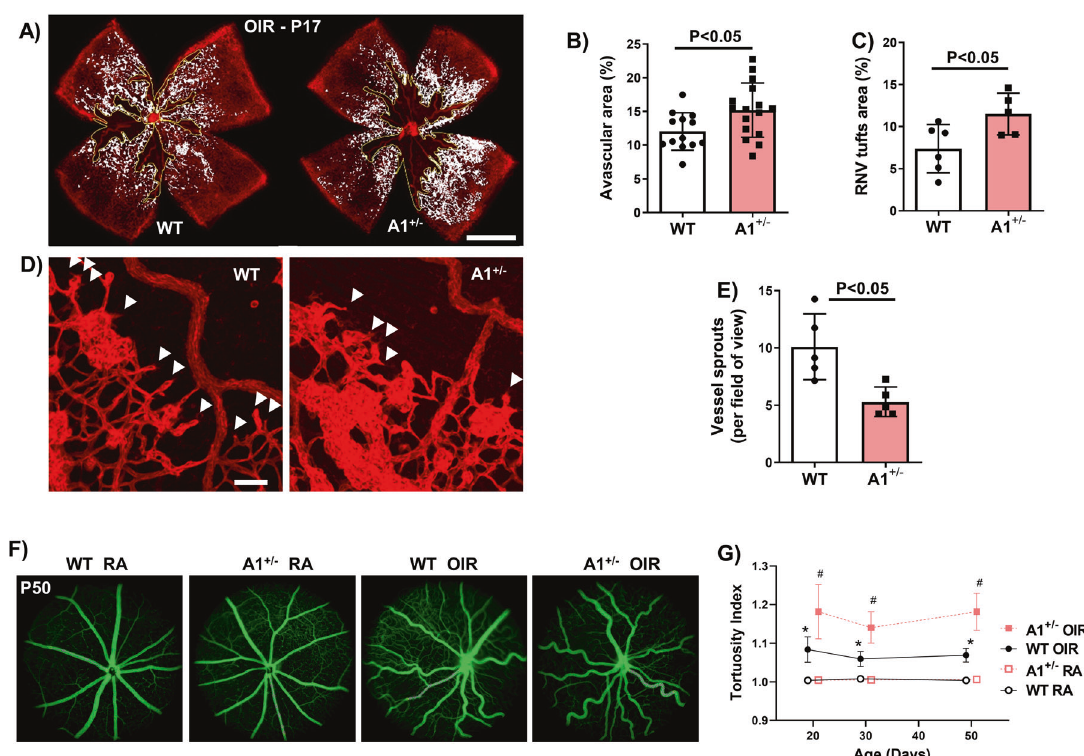
Fig. 4 A1 deletion increases pathological neovascularization and decreases vascular repair at P17. A – C WT and A1 KO littermates were subjected to OIR at P7 and prepared for analysis on P17. Avascular area (AVA, yellow outline) and pathological RNV (tufts, highlighted in white) were signi fi cantly increased in A1 KO retinas. Scale bar = 100 µm. D , E Higher magni fi cation images show decreased vessel sprouts at the AVA border zone of the P17 lectin-labeled A1 KO retina fl atmounts. Scale bar = 20 µm. F , G Fluorescein angiography images show persistent